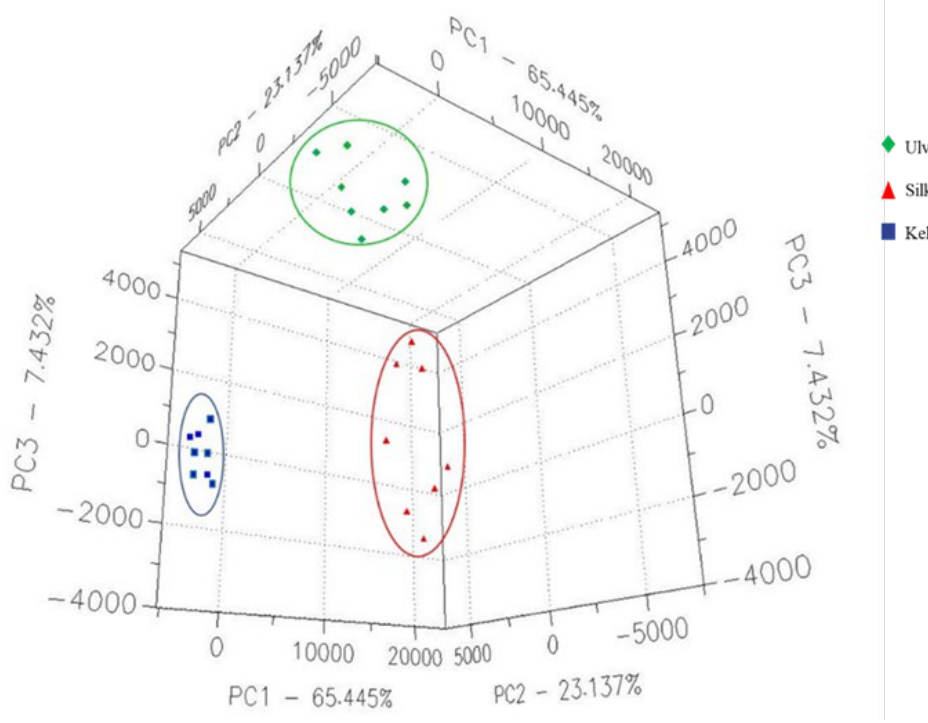
Figure 1. PCA model built with the electronic nose data related to the Kelp, Ulva, and Silk algae.